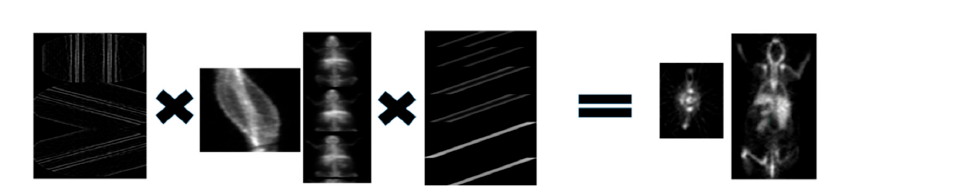
Figure 3. Workflow of the reconstruction process. 3D data are multiplied PINVs of the axial and transaxial SRMs in a single